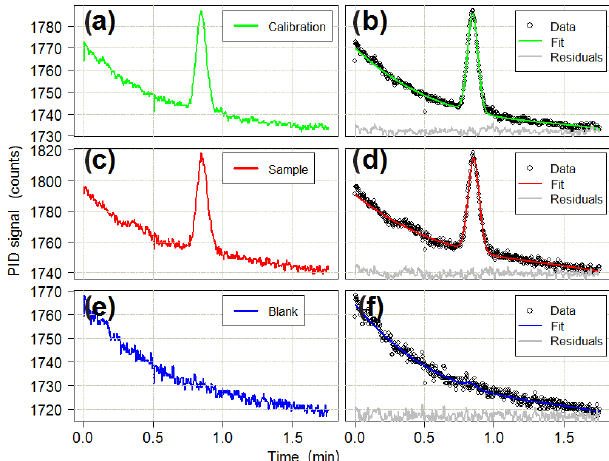
Figure 3. Typical chromatograms for (a) calibration, (c) sample and (e) blank runs. The isoprene peak detected by the PID is around the 0.8min mark. Panels (b) , (d) and (f) show the combined baseline and Gaussian fits to the observed data for each run type. Resid- uals are offset for clarity. All of the chromatograms are from the deployment in the Wytham Woods field campaign (see Sect. 5.3). The calibration run is for 12mL of a 11.6ppb standard of isoprene in a nitrogen balance. The sample run is for a 150mL ambient air sample (later quantified as 1.5ppb isoprene). The blank run is for a 12mL sample of grade 5.0